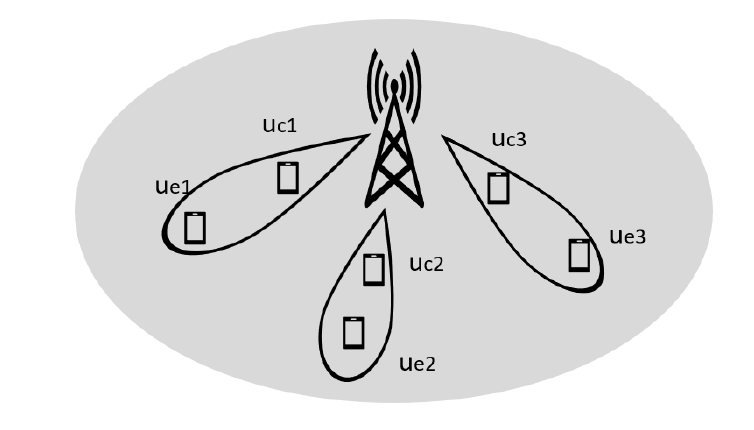
Figure 1. NOMA-based scheme network